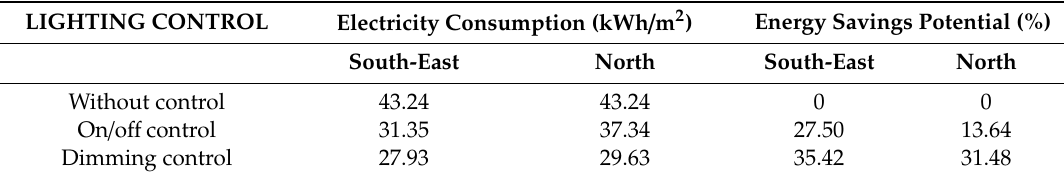
Table 1. Electricity consumption and energy savings